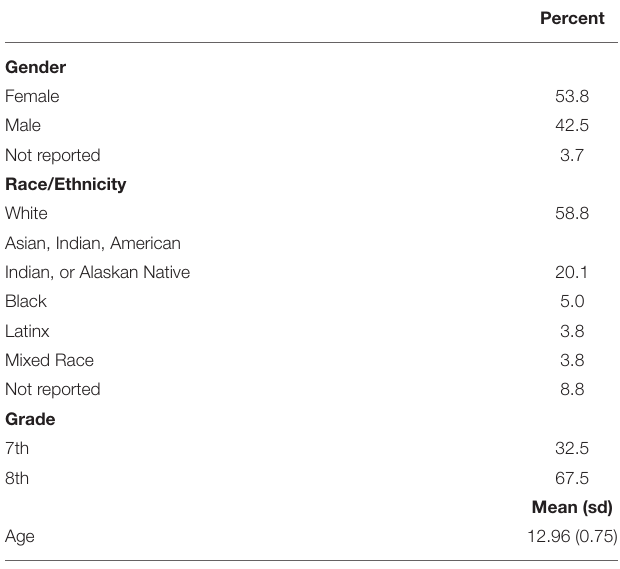
TABLE 1 | Validation sample descriptives n =